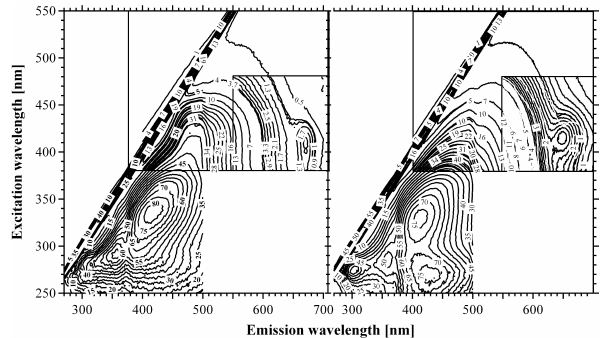
Fig. 8. Fluorescence excitation-emission matrices of a sample taken at the surface (left panel) and at 200-m depth (right panel) in the east Atlantic Ocean during ANT-XXV/1. Each graph shows a composite of three matrices recorded from the same sample with different detector amplification to adjust for the low fluorescence emission at longer wavelengths. Note that fluorescence is given in arbitrary units and amplification differences between measurements are not adjusted to see the otherwise faint Ex/Em maxima at longer wavelength in more